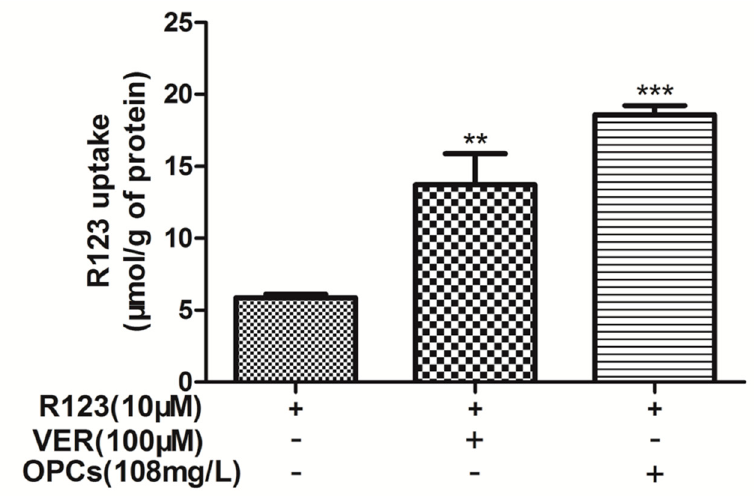
Figure 5. The effects of OPCs on R123 accumulation in Caco-2 cells were investigated at 108 mg/L. Verapamil (100 μ M) was used as positive control. Data are presented as mean ± SEM of three independent experiments. ** p < 0.01, *** p < 0.001 vs. control.